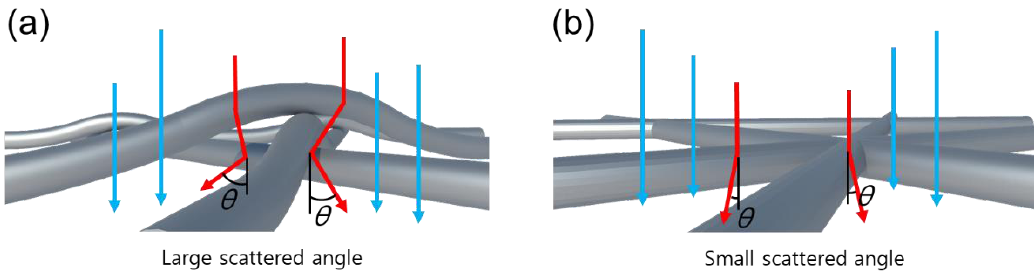
Figure 6. The illustration explains the reason for the change in the optical properties when a 2D Ag nanomesh is formed from a 3D AgNW network. ( a ) large scattered angle when it shaped 3D AgNW network, ( b ) small scattered angle when it shaped 2D Ag nanomesh